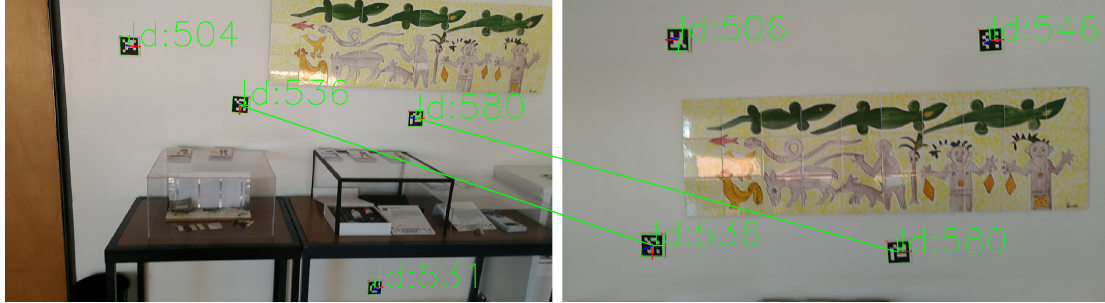
Figure 2. Detection and matching of aruco markers in a pair of